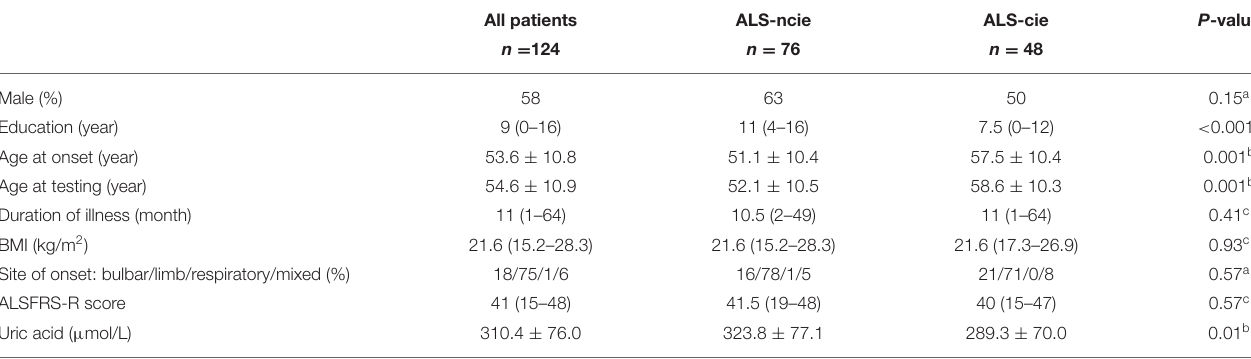
TABLE 1 | Clinical characteristics of ALS patients.